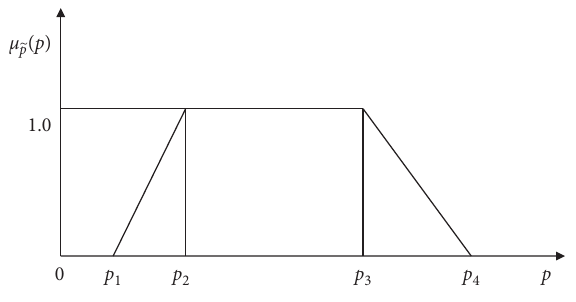
Figure 1: Representation of the membership function μ